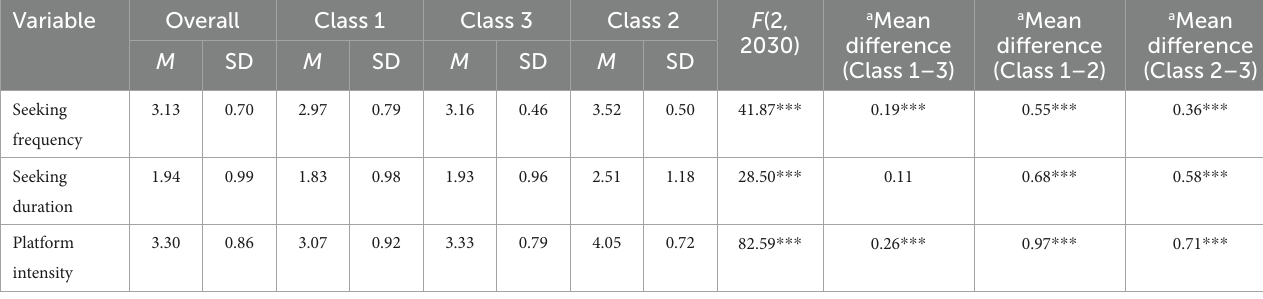
TABLE 4 Class comparison on health information